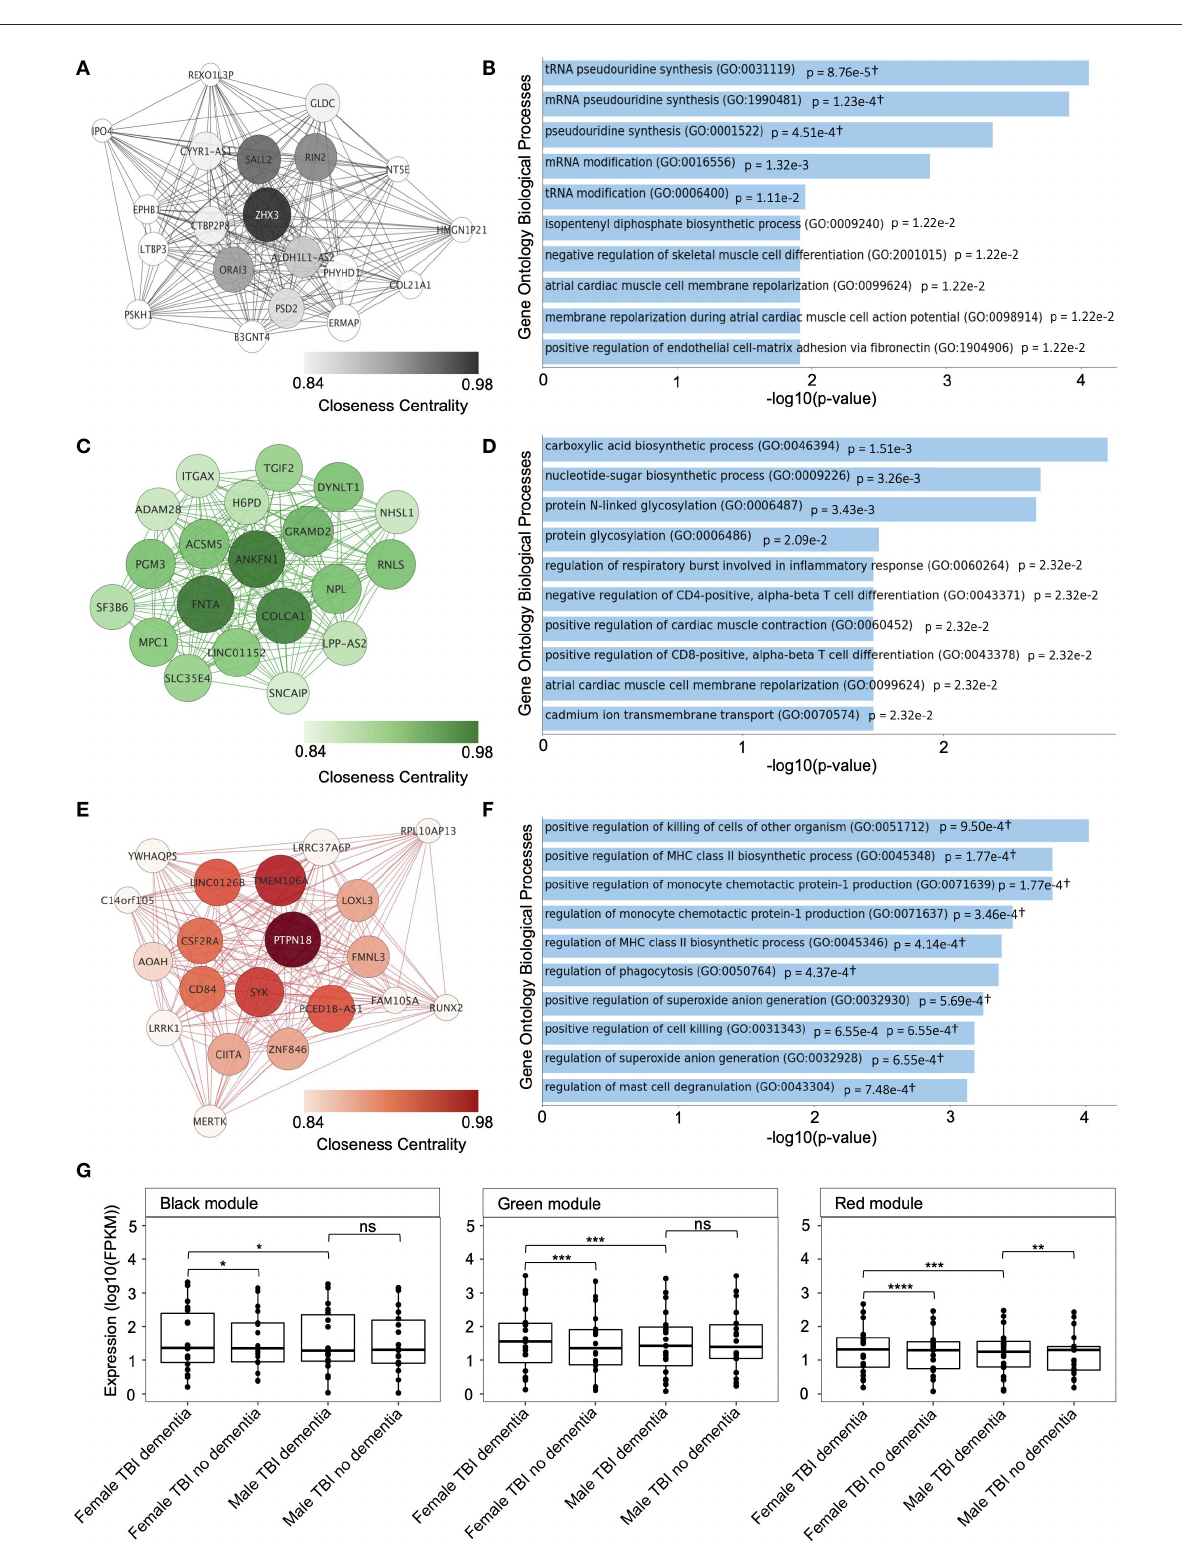
FIGURE3 Top hub genes and module-specific gene set enrichment analysis (GSEA) of candidate modules from the female hippocampus. (A) Interaction networks of the top 20 genes with the highest connectivity (hub genes) in the black candidate module, identified in the weighted